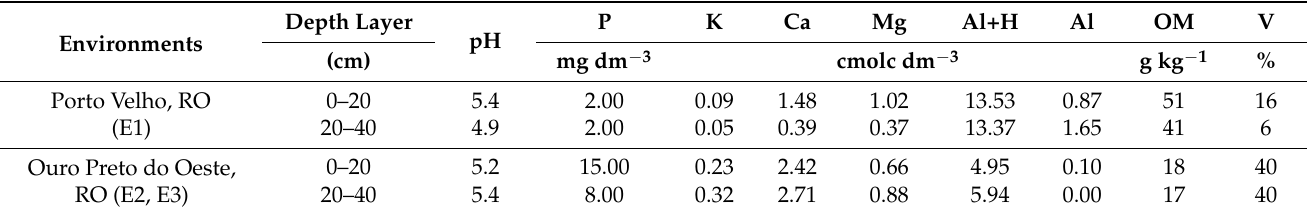
Table 1. Chemical properties at the 0–10 and 20–40 depth layers of clonal competition trials conducted in two contrasting environments of the Western Amazon.